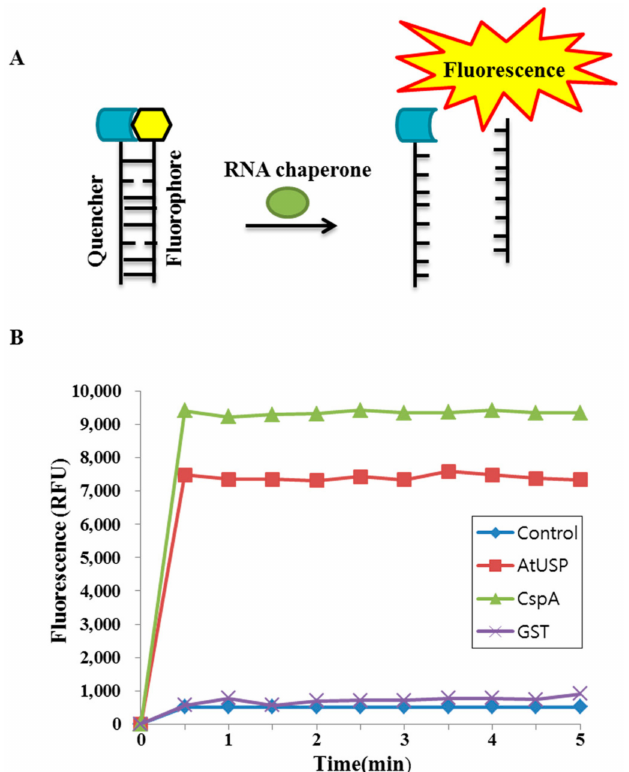
Figure 5. Nucleic acid-melting activity of AtUSP using a molecular beacon substrate. ( A ) Schematic diagram of DNA-melting activity of AtUSP, which was analyzed using a molecular beacon substrate. F, fluorophore (FITC); Q, fluorescence quencher. ( B ) Effect of AtUSP, cold-shock protein A (CspA), and GST on DNA melting using a molecular beacon substrate. Emitted fluorescence intensity was measured at various times after incubating AtUSP, CspA, GST, and buffer alone (control) with the molecular beacon. Excitation and emission wavelengths were 555 and 575 nm,